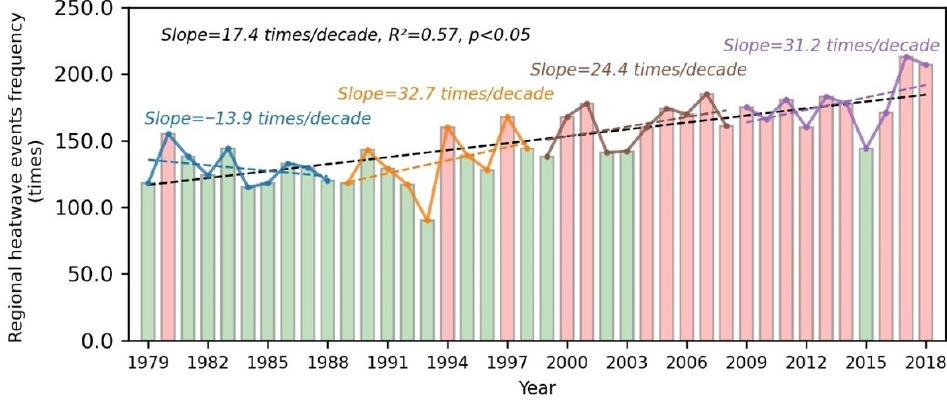
Figure 3. Variations in frequency of heatwave events in the 1979–2018 period across China. Green bars represent the number of heatwave events less than the average of 150 times, while the red bars denote above 150 times; distinguished colors for lines illustrate change trends in different periods as: 1979–2018 (black), 1979–1988 (blue), 1989–1998 (orange), 1999–2008 (brown), and 2009–2018 (pur- ple).